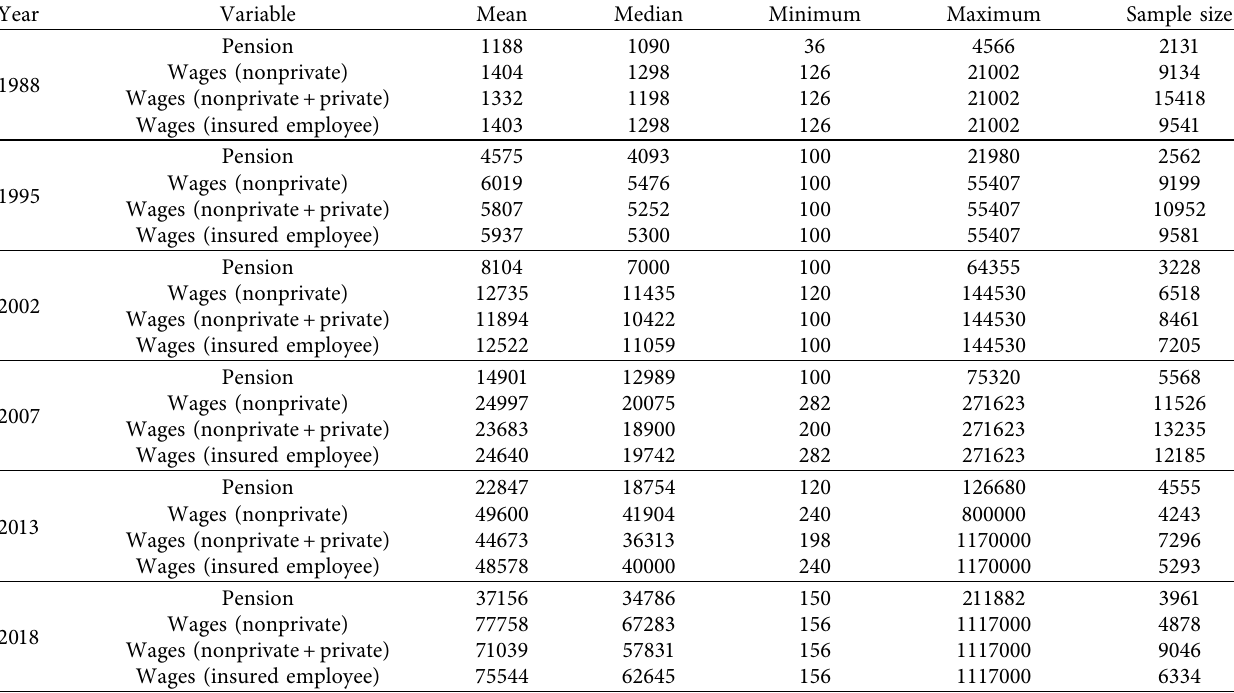
Table 1: Descriptive statistics of data (unit: yuan, sample size: